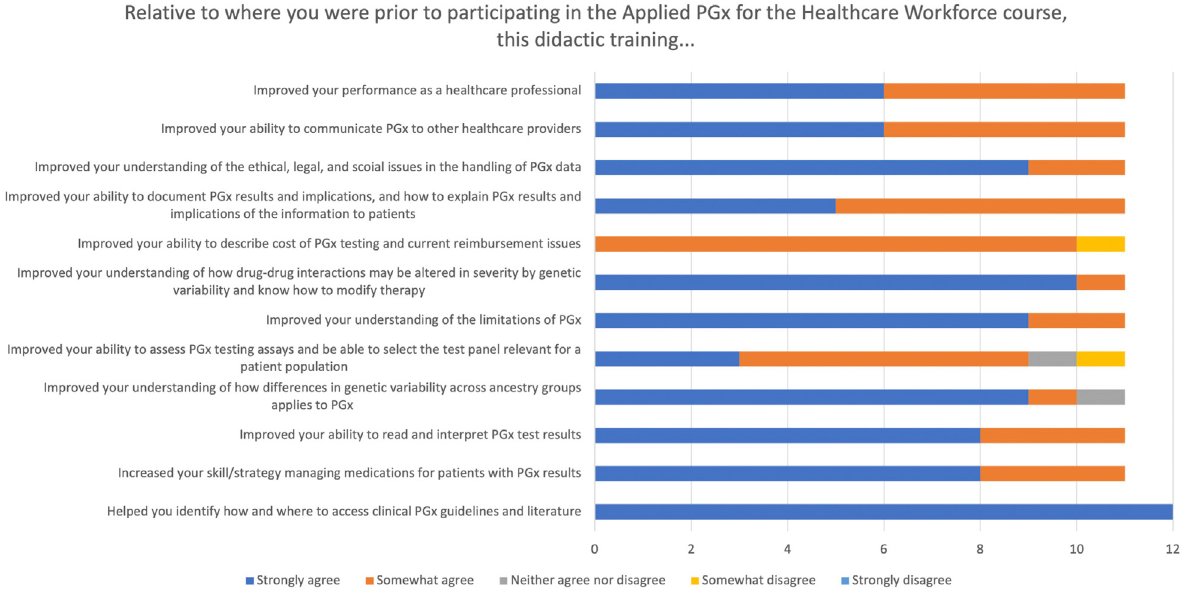
FIGURE 3 Participant responses to the didactic course evaluation.